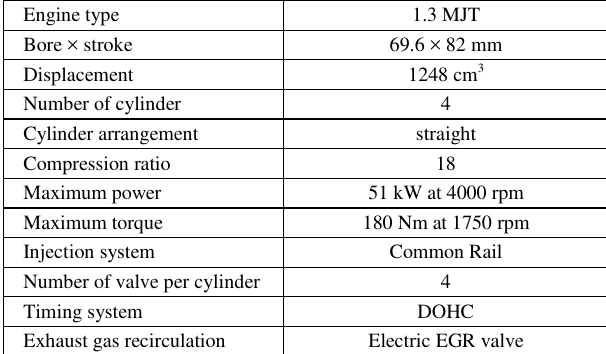
Table 1. Technical data of the Fiat 1.3 MJT engine